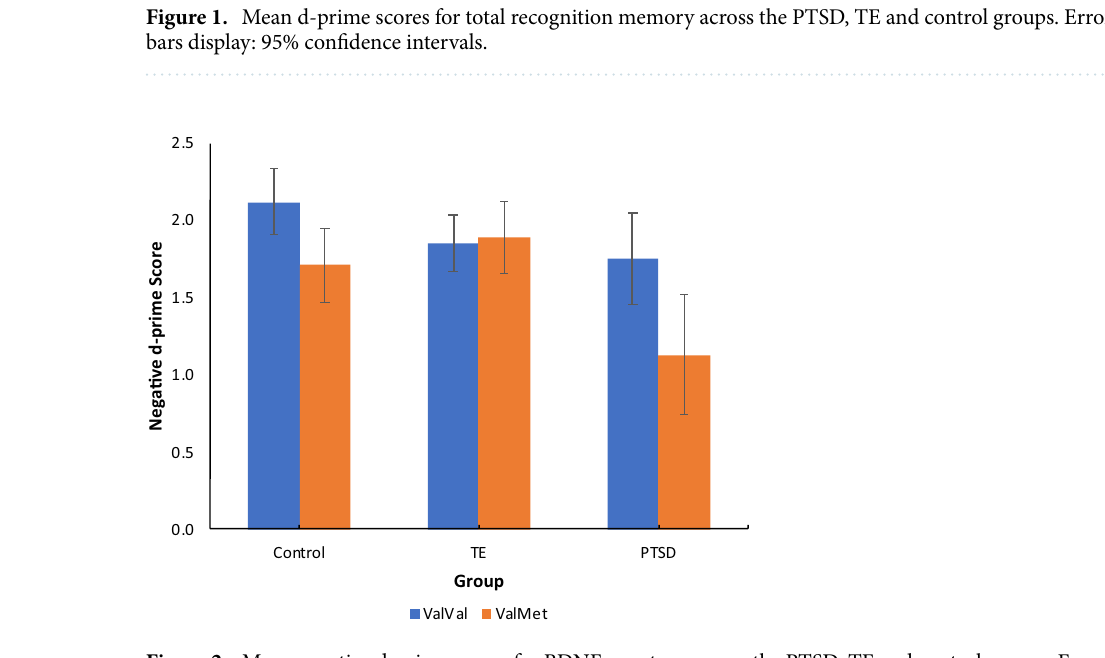
Figure 2. Mean negative d-prime scores for BDNF genotype across the PTSD, TE and control groups. Error bars: 95% confidence